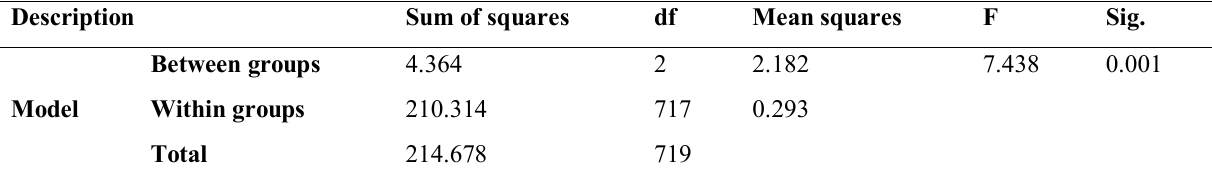
Table 8- ANOVA (Comparing the financial performance of investment quartiles)